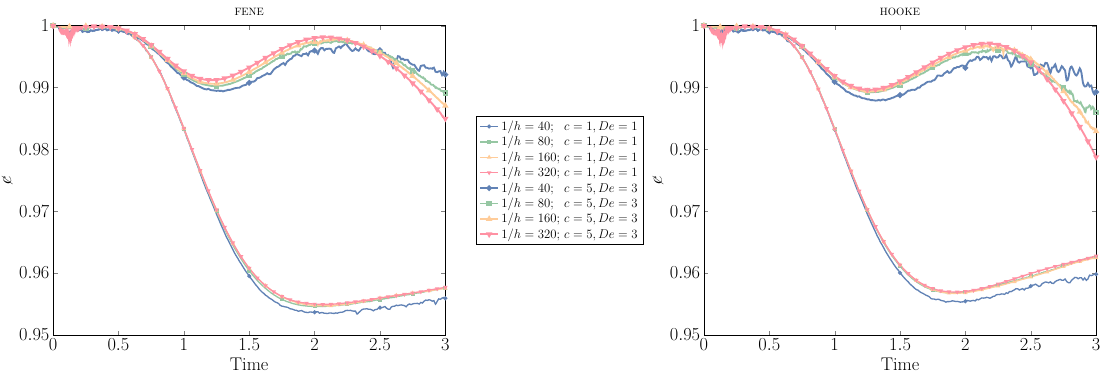
Figure 7. Evolution of the circularity of a drop rising due to buoyancy effects in a polymer solution, using the FENE and Hookean kinetic models, variable mesh size h = { 1/40,1/80,1/160,1/320 } , and different degrees of viscoelasticity: c = 1, De = 1; and c = 5, De = 3.